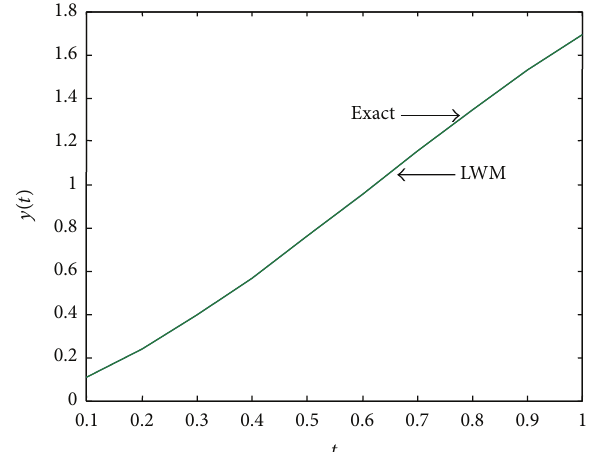
Figure 2: Numerical results of Example 1 by LWM for different values of 𝛼